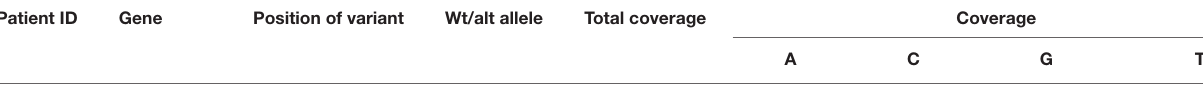
TABLE 2 | Summary of NGS results. Patient